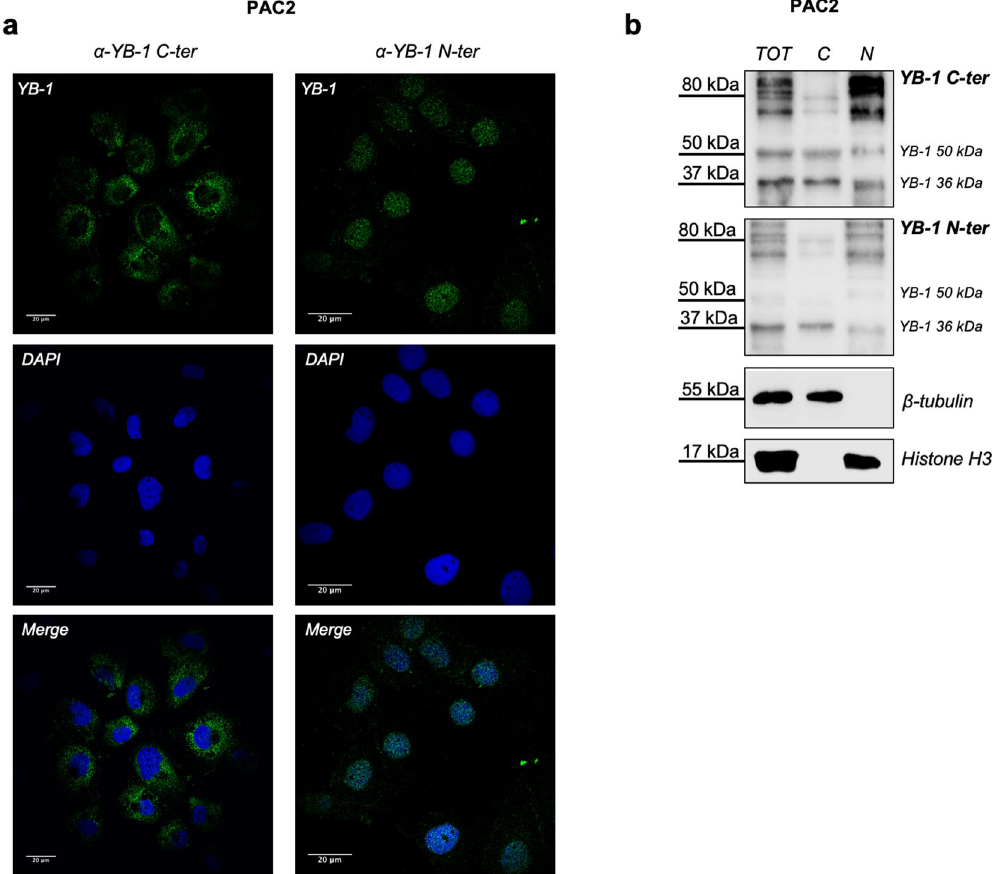
Figure 1. Immunoreactivity of human YB-1 antibodies against zebrafish YB-1. ( a) confocal immunofluorescence analysis of PAC2 cells stained with human YB-1 antibodies ( α -YB-1 C-ter and α -YB-1 N-ter), nuclei were stained with DAPI (blue); ( b ) western blot of PAC2 total ( TOT ), Cytoplasmic ( C ) and nuclear (N) protein extracts analysed with α -YB-1 N-ter and α -YB-1 C-ter antibodies; Histone H3 and ß-tubulin were used as loading controls for the nuclear and cytoplasmic extracts, respectively. Each panel is assembled from cropped western blotting images (see Supplementary Material file for the original